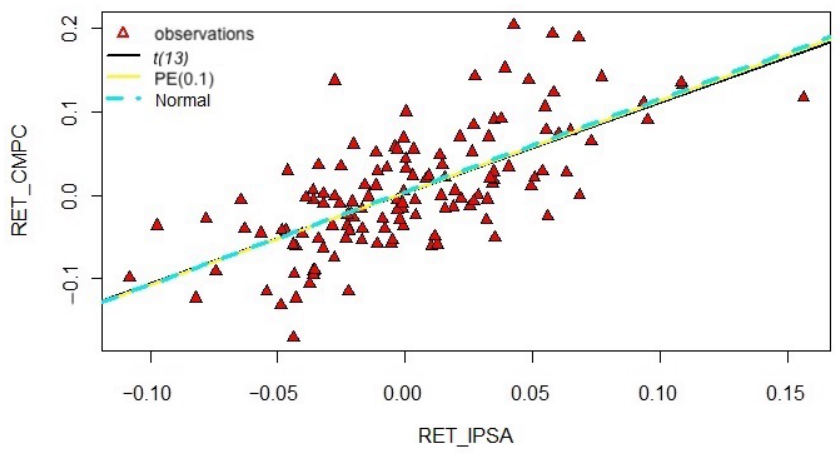
Figure 9. Scatter plot of monthly returns for the IPSA and CMPC with fitted CAPM lines under the normal, Student-t, and PE distributions.